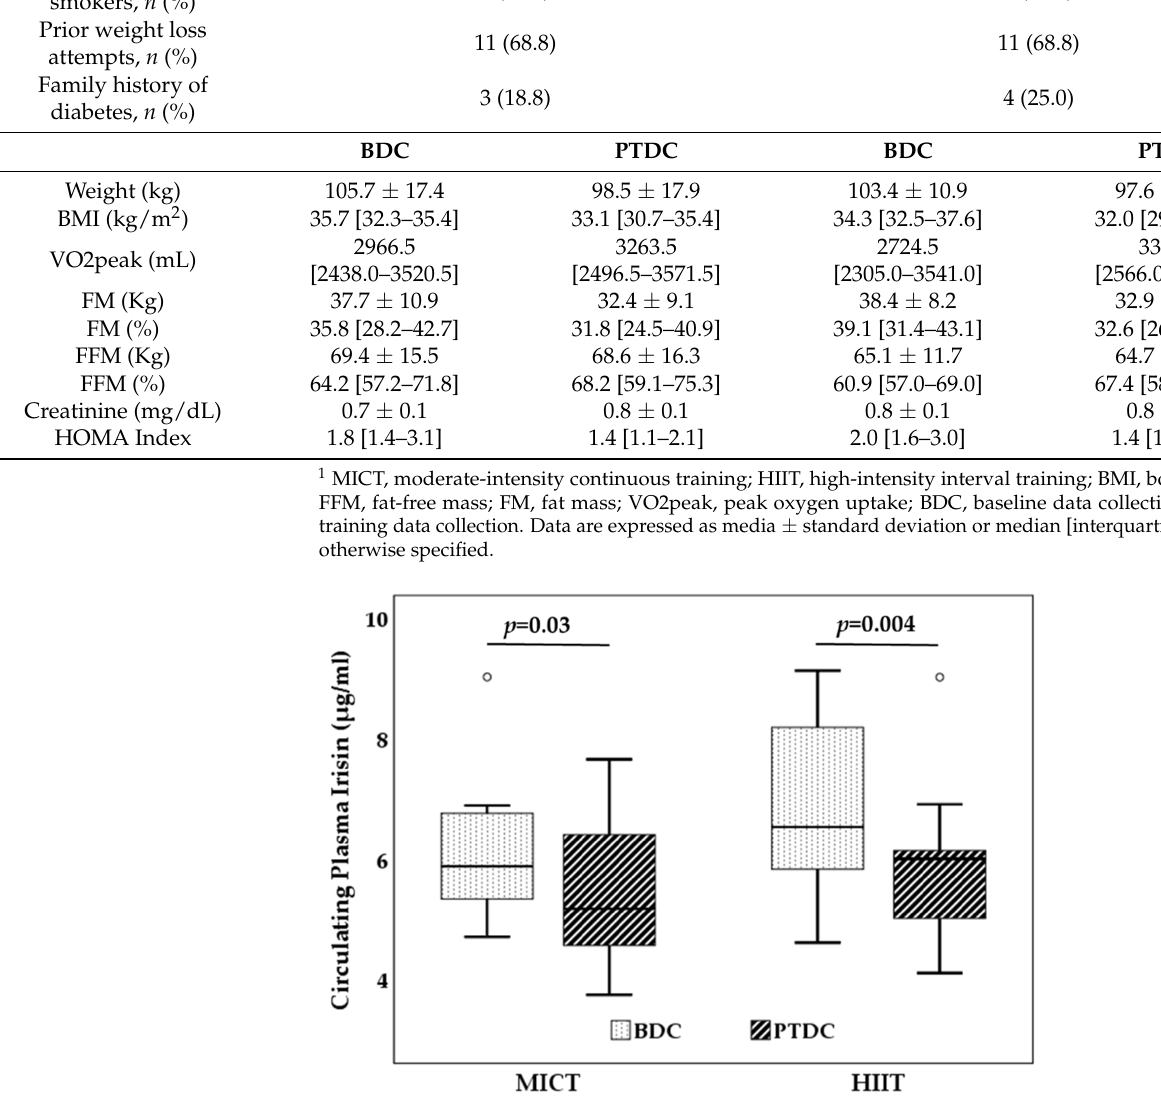
Figure 1. Changes in circulating level of irisin after the aerobic training of 12 weeks: MICT and HIIT groups. BDC, baseline data collection; PTDC, post training data collection; MICT, moderate-intensity continuous training; HIIT, high-intensity interval training.